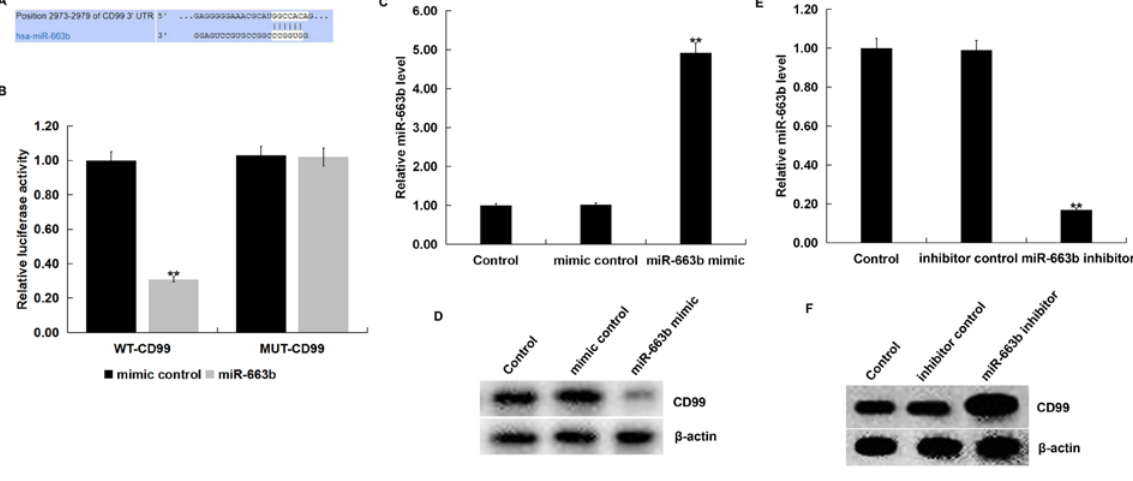
Figure 2. CD99 is the target gene of miR-663b. (A) Binding sites between CD99 and miR-663b were predicted using TargetScan. (B) Dual-luciferase reporter assays were performed to reveal the prediction. **p<0.01 vs. mimic control. (C) qRT-PCR assay detected the expression of miR-663b in Jurkat T cells that were trans- fected with mimic control or miR-663b mimic for 48 h. **p<0.01 vs. Control. (D) Western blot assay detected the protein expression of CD99 in Jurkat T cells that were transfected with mimic control or miR-663b mimic for 48 h. (E) qRT-PCR assay detected the expression of miR- 663b in Jurkat T cells that were transfected with inhibitor control or miR-663b inhibitor for 48 h. **p<0.01 vs. Control. (F) Western blot assay detected the protein expression of CD99 in Jurkat T cells that were transfected with inhibitor control or miR-663b inhibitor for 48 h.